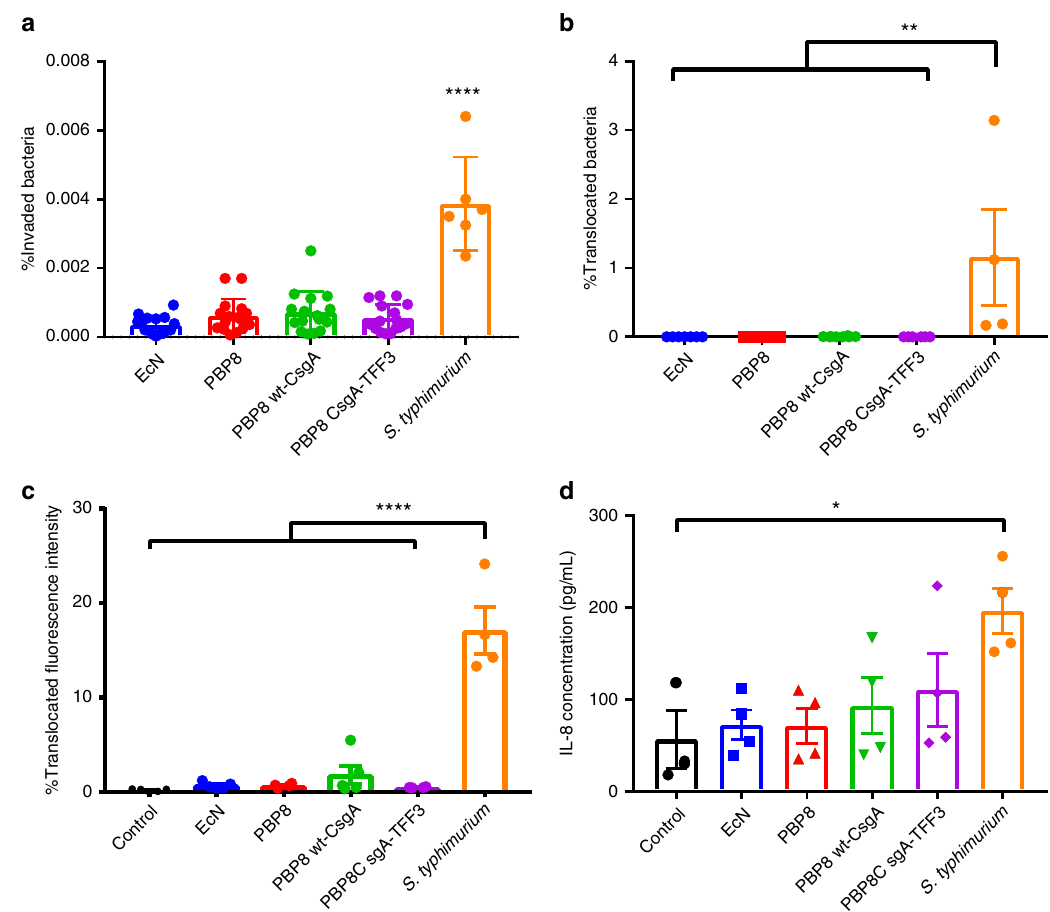
Fig. 3 Effects of curli fi ber expression on EcN pathogenicity. a Percent of bacteria that invaded a monolayer of Caco-2 after 2 h of co-incubation with EcN, PBP8 variants, and S. typhimurium . b Bacterial translocation to the basolateral compartment of polarized Caco-2 cells exposed to bacterial library for 5 h. c Epithelial permeability of polarized Caco-2 24 h post-infection, quanti fi ed via FITC-dextran (MW 3000 – 5000) translocation. d IL-8 secretion from the basolateral compartment of polarized Caco-2 cells 24 h post-infection. Data are represented as mean ± SEM. (ns) p > 0.05, * p ≤ 0.05, ** p ≤ 0.01, *** p ≤ 0.001, **** p ≤ 0.0001, one-way ANOVA followed by Tukey ʼ s test. Source data are provided as a Source Data fi